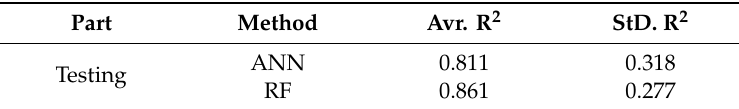
Figure 8. Scatter plot of R 2 values for 1.000 simulations for ( a ) RF, ( c ) ANN and the corresponding histograms of R 2 values, ( b ) RF, ( d ) ANN.